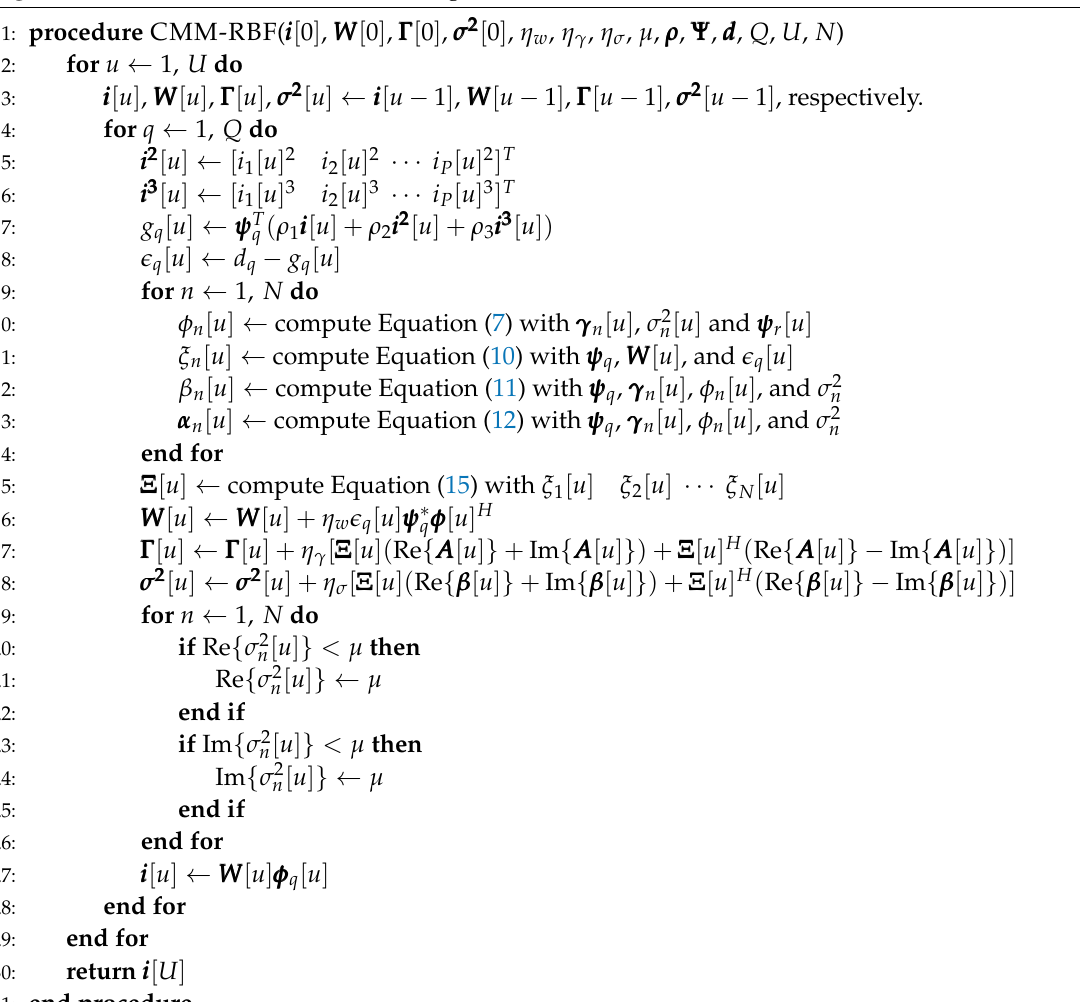
Algorithm A3 CMM-RBF for beamforming.